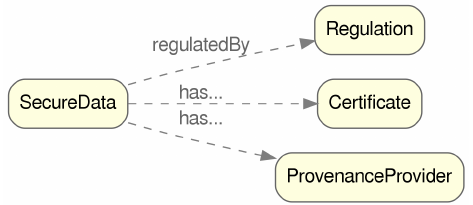
Figure 7. Object properties related to SecureData.